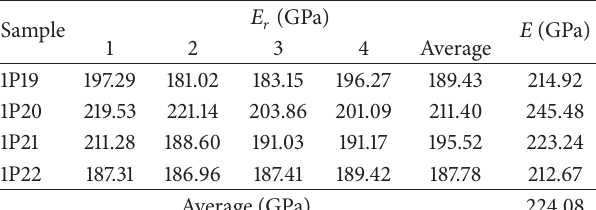
Table 2: LS SiN Young’s modulus experiment.